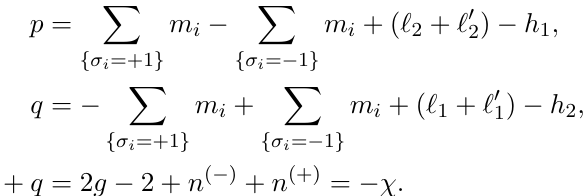
1, and ‘ 1 + ‘ 2 = 2 ; n 1 + n 2 = ‘ 0 (cid:0)